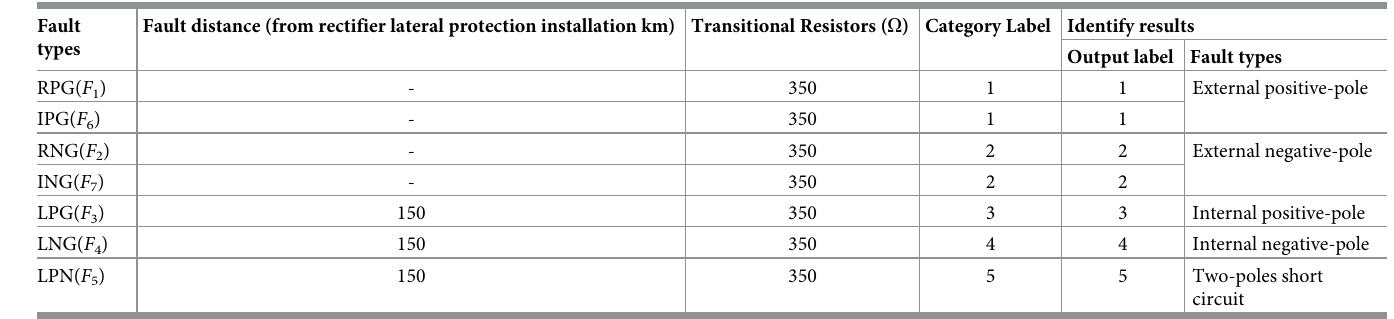
Table 4. Simulation verification results when different types of faults occur. Fault